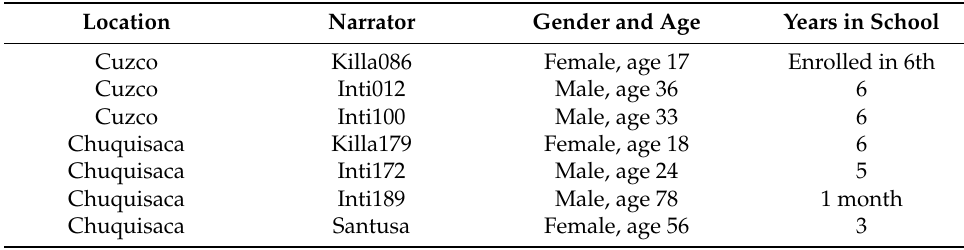
Table 3: Table 3. Characteristics of